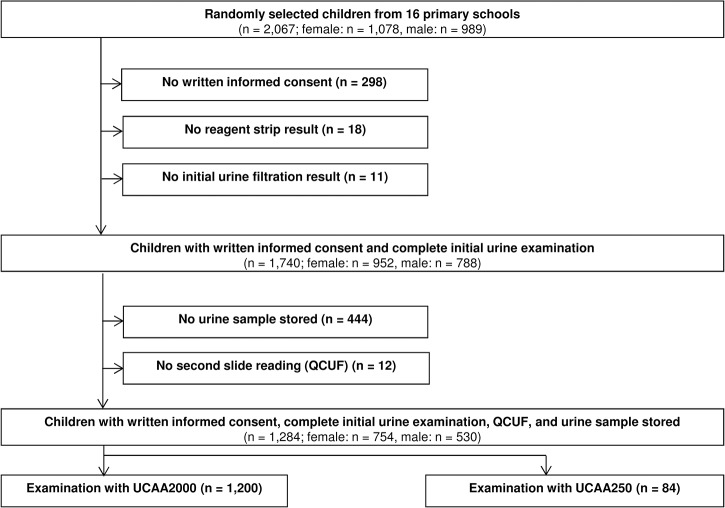
Flowchart detailing study participation and urine sampling procedures.Flowchart indicating the inclusion and exclusion of data for determining the accuracy of different methods for the diagnosis of Schistosoma haematobium in children from Pemba, United Republic of Tanzania, in 2013. UCP-LF CAA: up-converting phosphor-lateral flow assay detecting circulating anodic antigen in urine; UCAA2000: UCP-LF CAA prepared with 1.5 ml of urine; UCAA250: UCP-LF CAA prepared with 250 μl of urine.